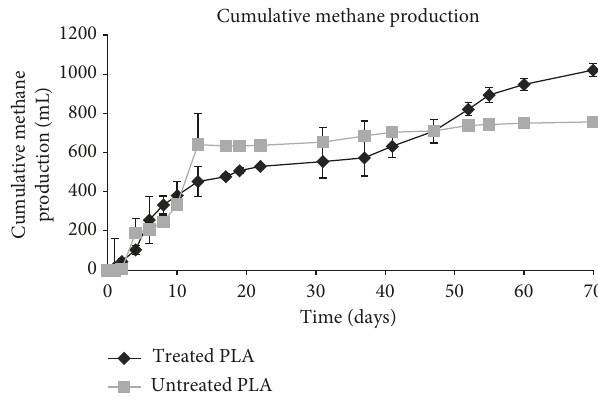
Figure 4: Methane production of food waste and PLA (treated or untreated). Error bars in graph represent standard deviation (methane production of PLA at day 70 adjusted to subtract gas produced from negative